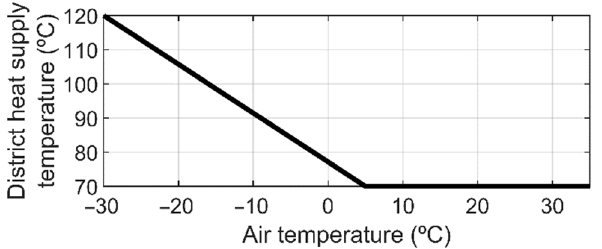
Figure 4. Supply temperature of district heat varies as a function of ambient temperature. Reproduced from [45].